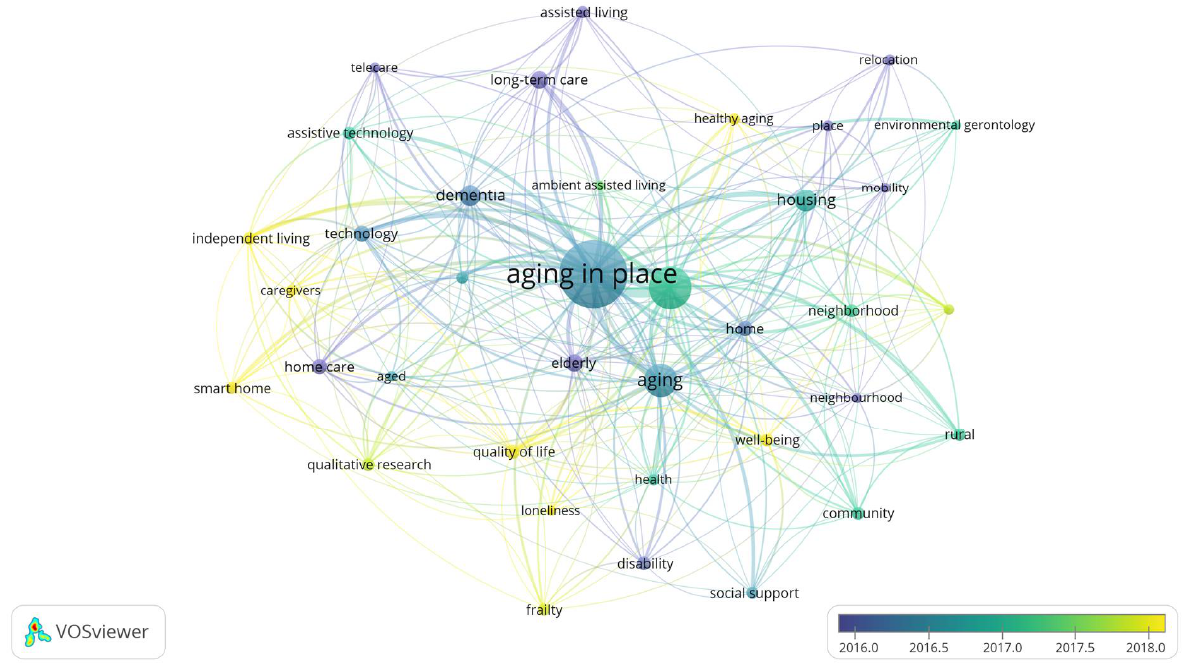
Figure 6. Overlay visualization of